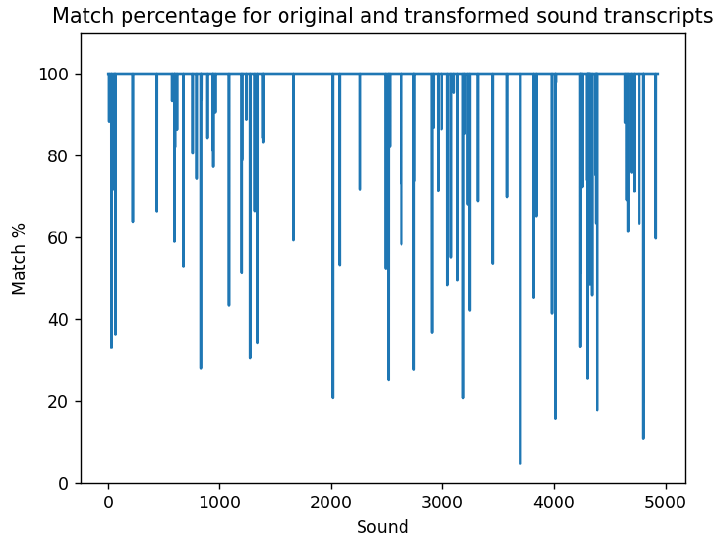
Figure 9. Transcription match pattern between original and neutralized